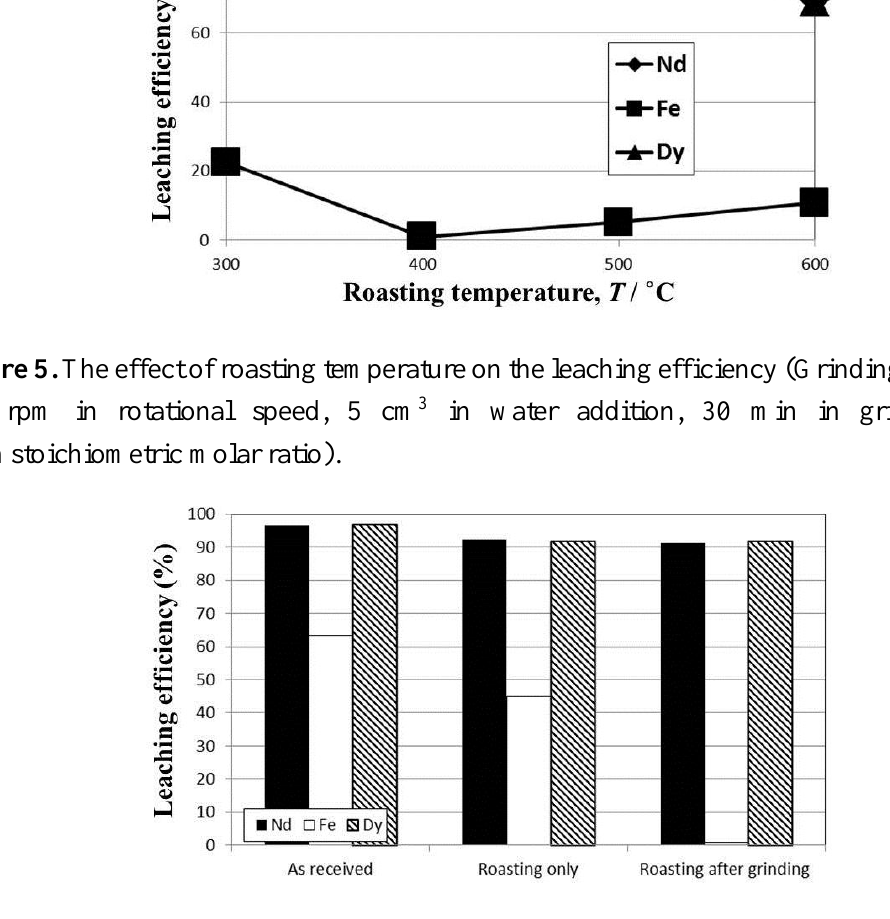
Figure 6. The comparison of leaching efficiencies using samples as as-received, only roasted, and roasted after being